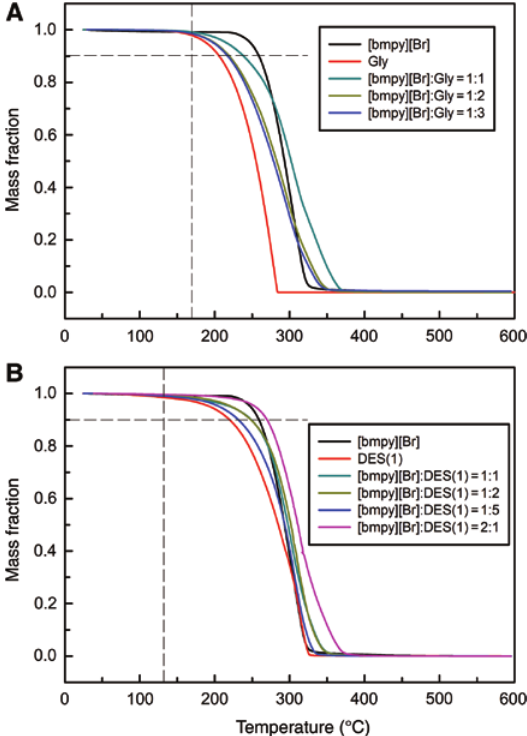
Figure 3: TGA curves of (A) BDES and single components and (B) TDES and single components. The BDES are composed of [bmpy][Br] and glycerol in different molar ratios, and the TDES is composed of [bmpy][Br] and DES(1) (ChCl:Gly = 1:2 molar ratio) in different mass ratios.